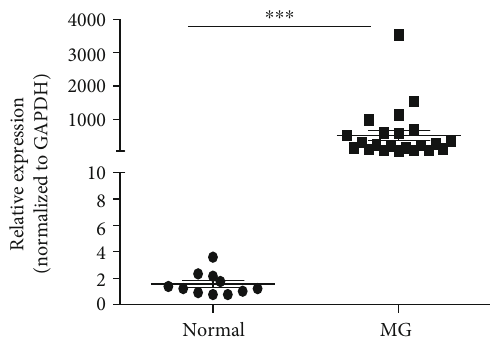
Figure 1: The relative expression level of G0S2 gene in the PMBC from MG patients and normal healthy volunteers. ∗∗∗ p < 0 : 01 vs. control. The y -coordinate represents the relative expression level, each dot represents an individual expression result, MG means the myasthenia gravis patients, and normal means healthy volunteers. The relative expression of G0S2 was normalized to the expression level of internal control gene